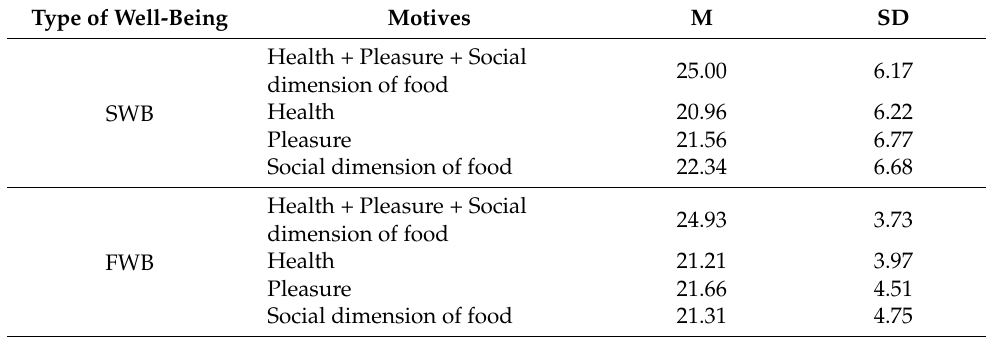
Table 5. The comparison of the average SWB and FWB levels of people driven by three motives and those motivated exclusively by the health issues or pleasure or social dimension of